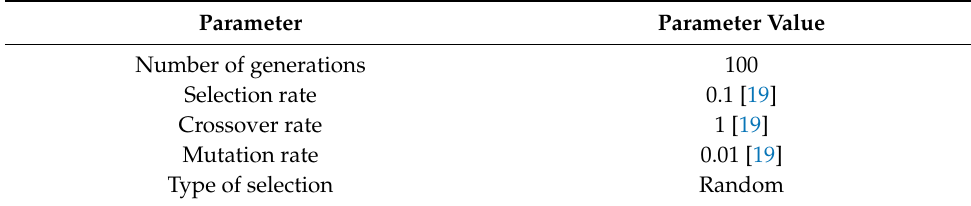
Table 3. List of GA parameters used in training phase.